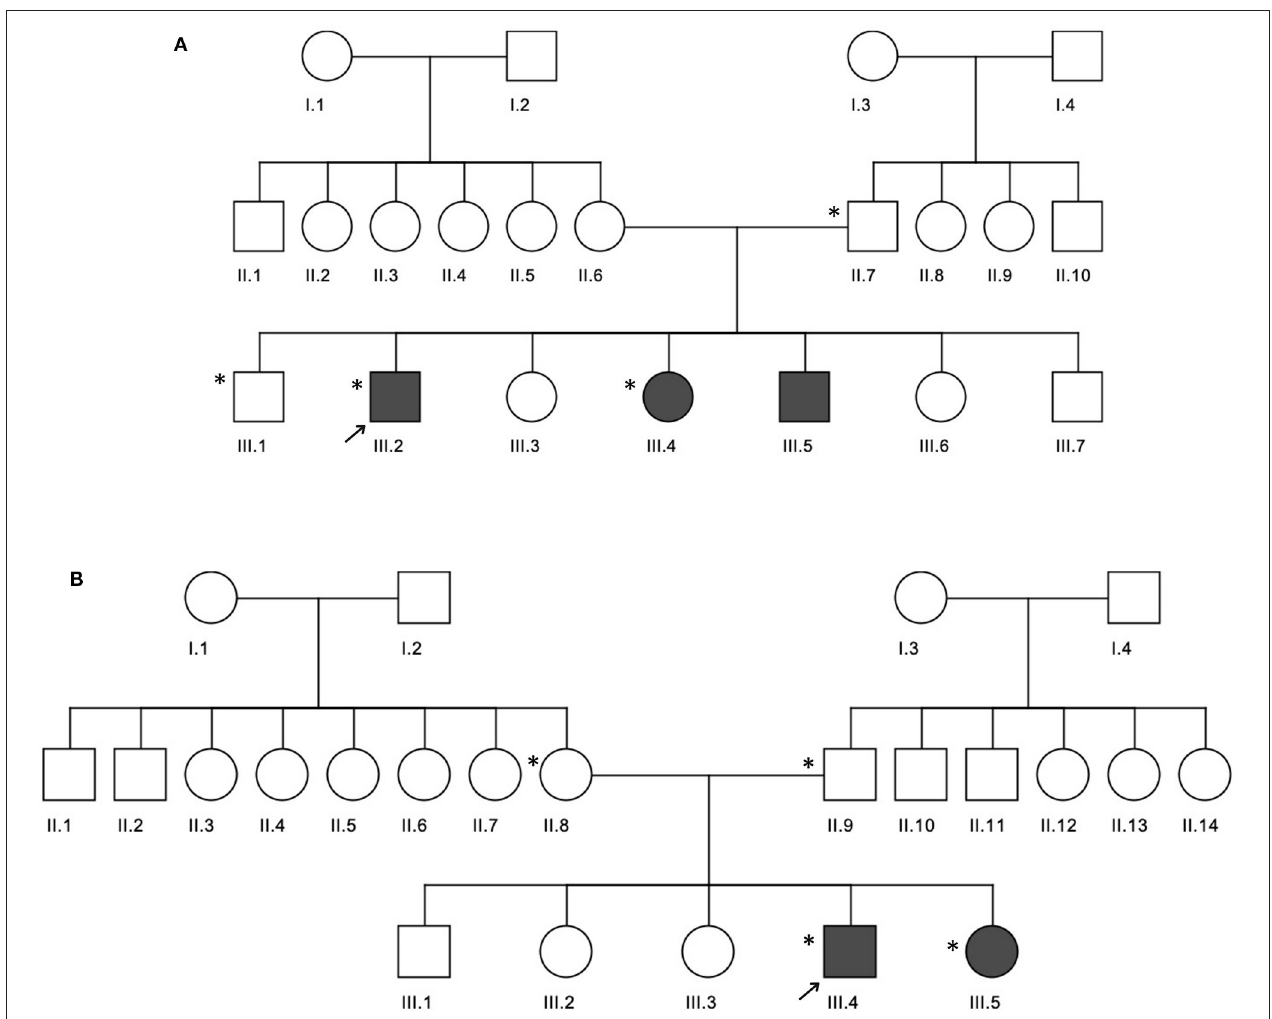
FIGURE 2 | Three generation pedigrees of celiac disease families. (A,B) The pedigrees for families A and B, respectively. The gray circle or boxes represent patients with celiac disease. Exome-sequenced individuals are indicated by the *